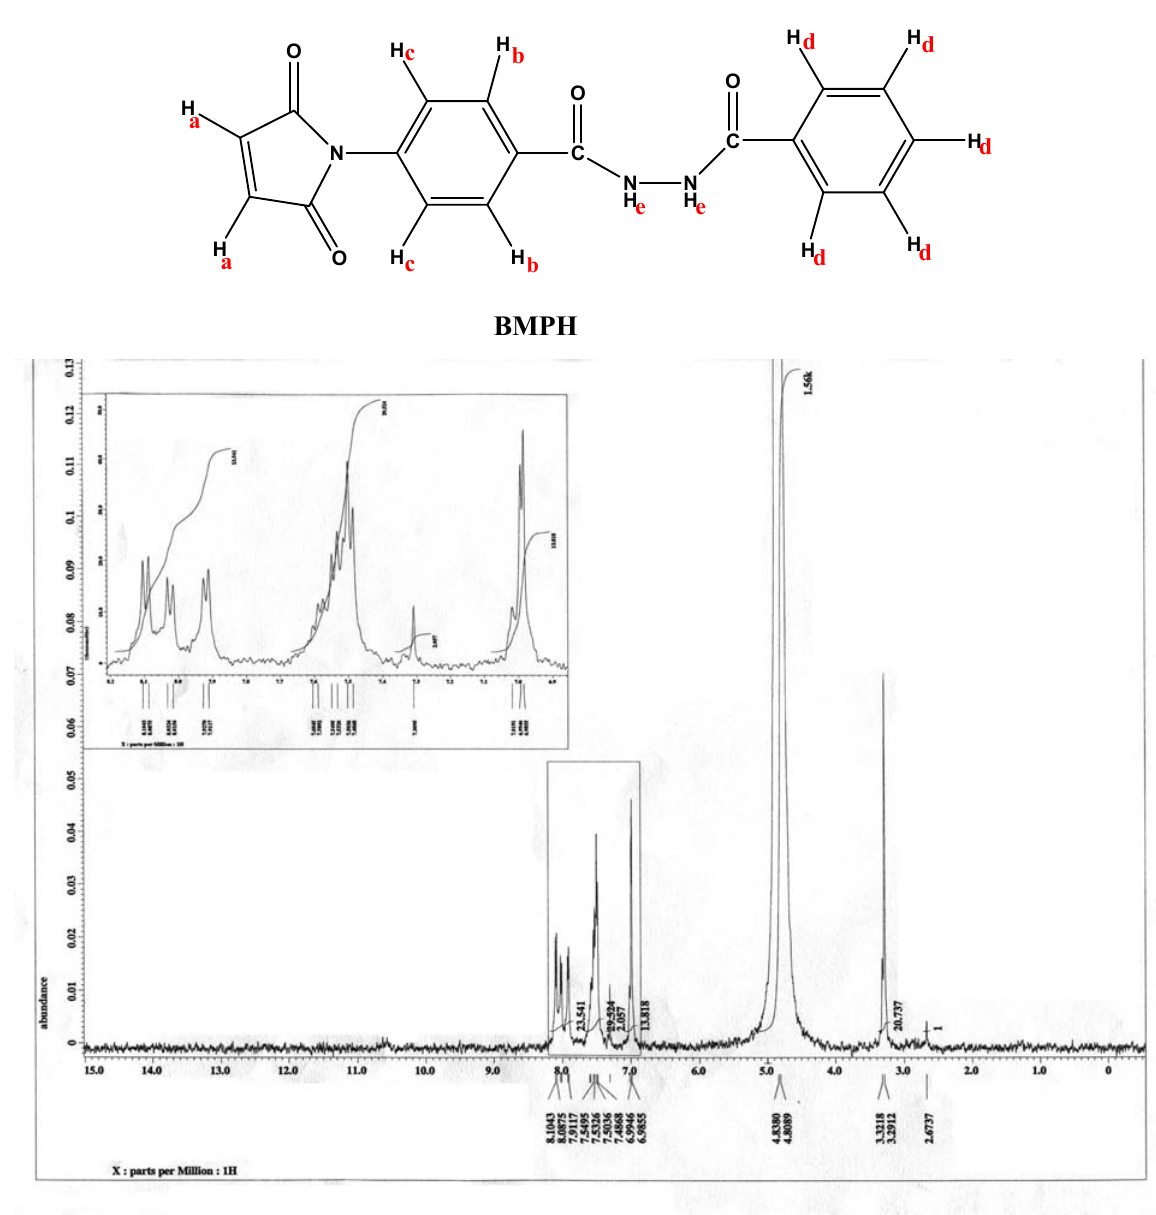
Figure 2. 1 H-NMR spectrum of